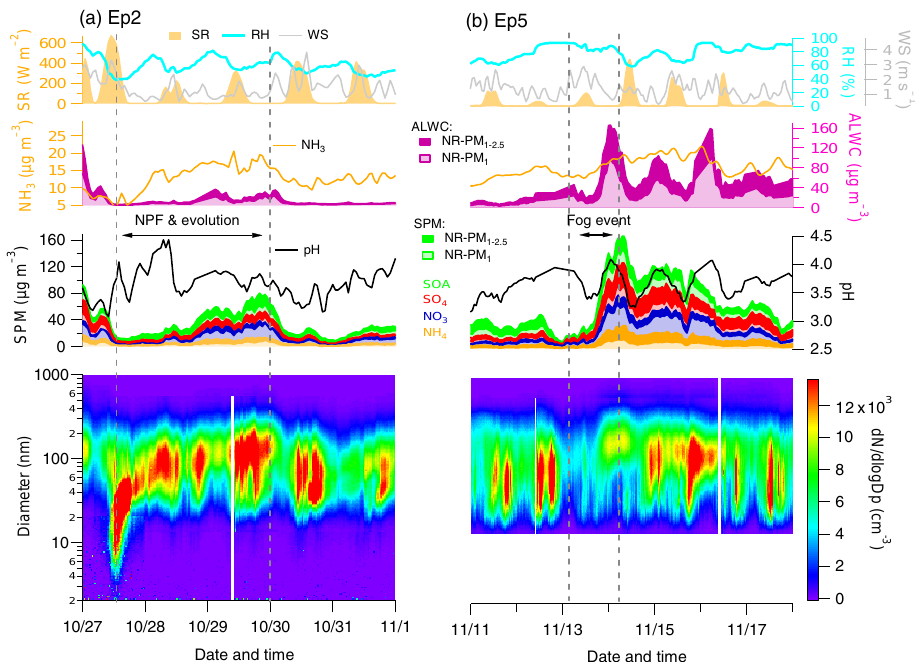
Figure 11. Evolution of meteorological parameters, secondary particulate matter (SPM), and the size distribution during two types of episodes (Ep2 and